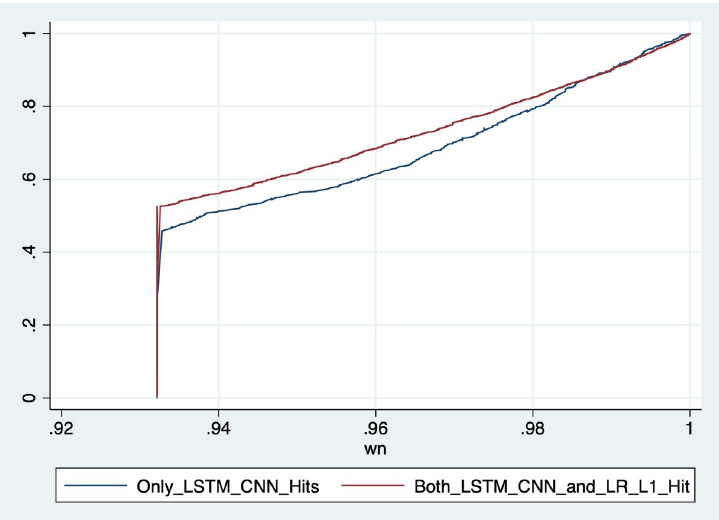
Fig 8. Cumulative density function curve of LSTM-LR-C (red line) and LSTM-C (blue line) . Figure shows that there are more patient records in the LSTM-C which have at least one chart event with high oscillation sequence. Essentially, compared to Logistic Regression, our LSTM+CNN model is capable of capturing high volatile time series behavior, a common pattern in high-risk ICU patients.